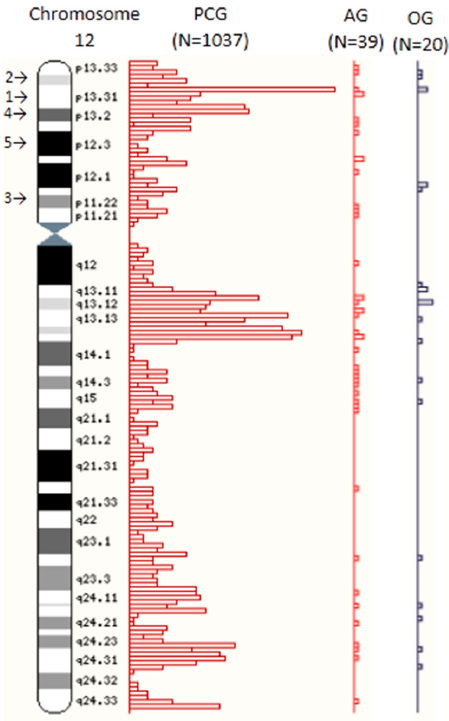
Figure 1. Sample chromosome ideogram with protein-coding, autism and obesity gene frequency distributions by Giemsa band.